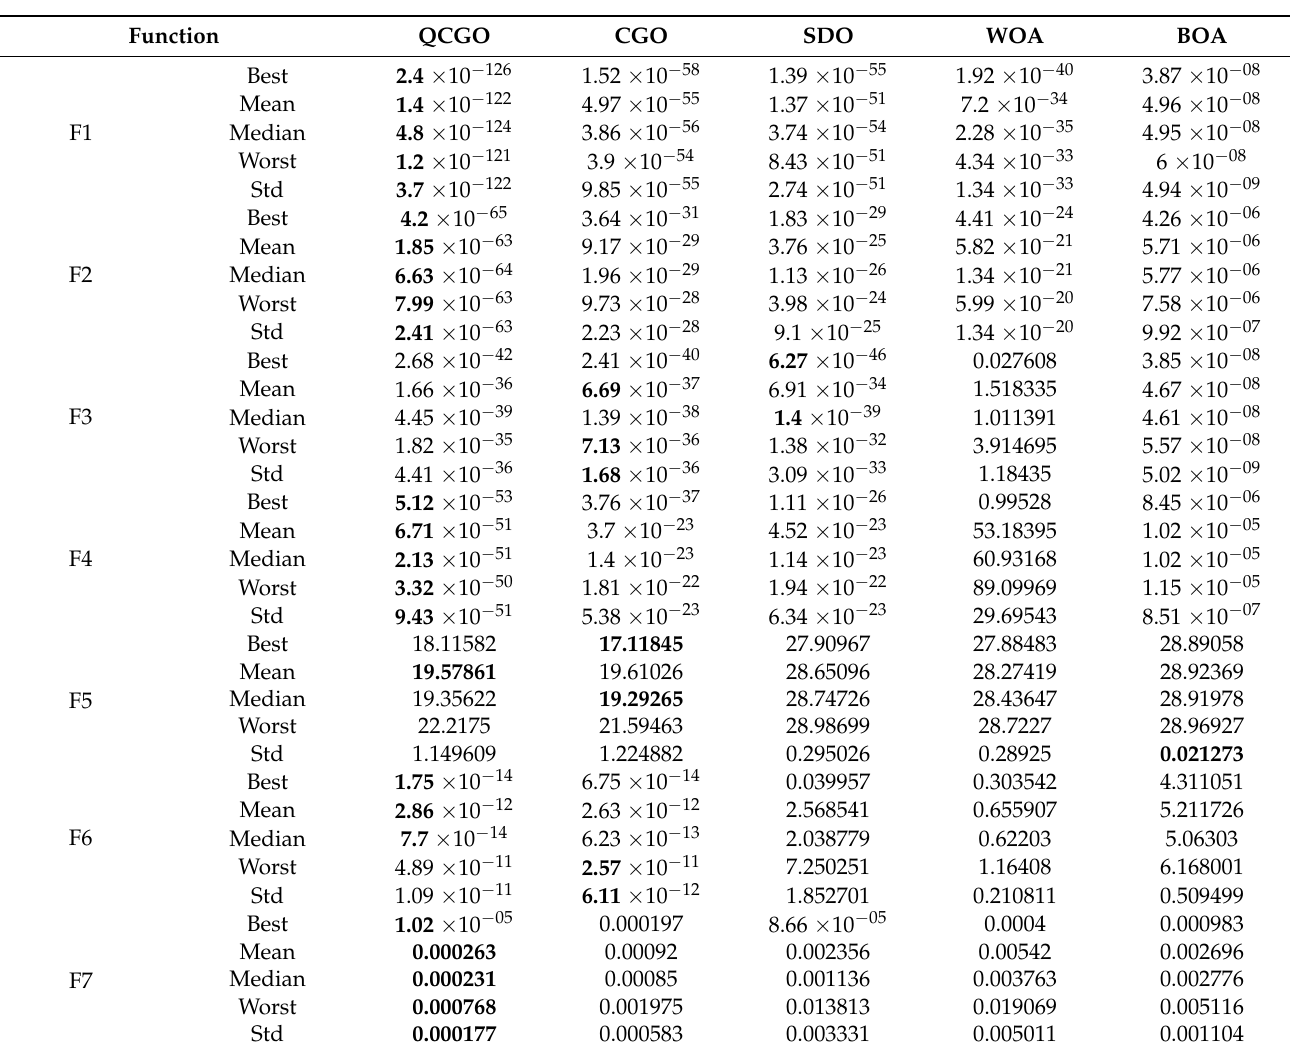
Table 4. Results of unimodal benchmark functions.